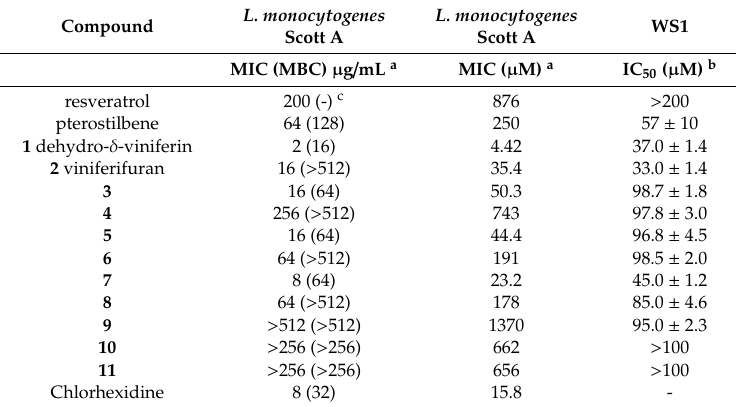
Table 1. Antimicrobial activity of synthesized compounds against L. monocytogenes Scott A a and cytotoxic activity on WS1 b